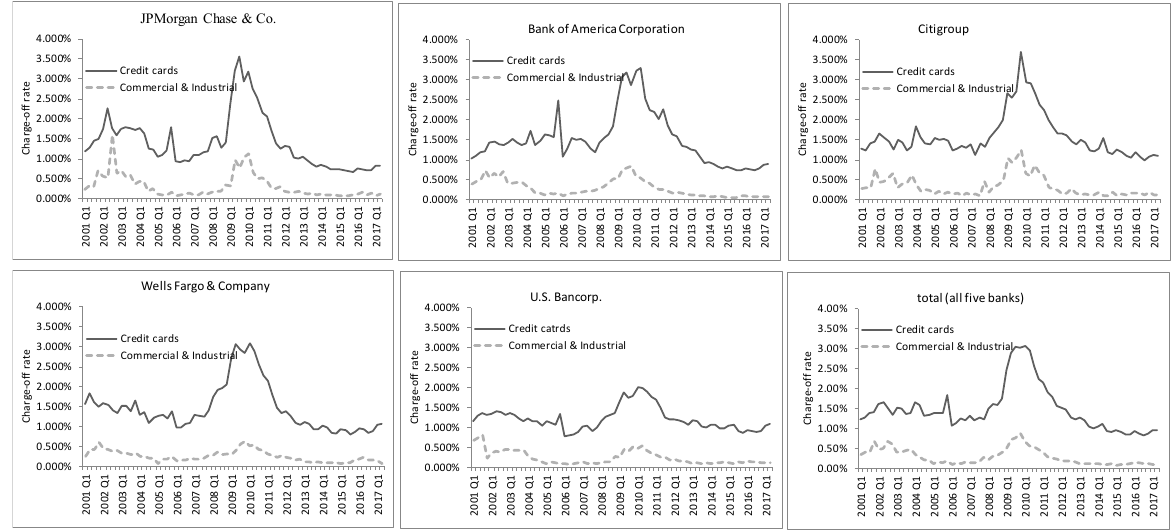
Figure 6. Charge-off rate time series.